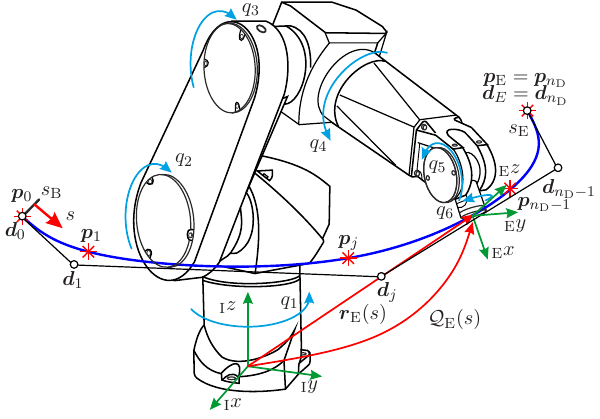
Figure 1. Six-axis industrial robot with geometric